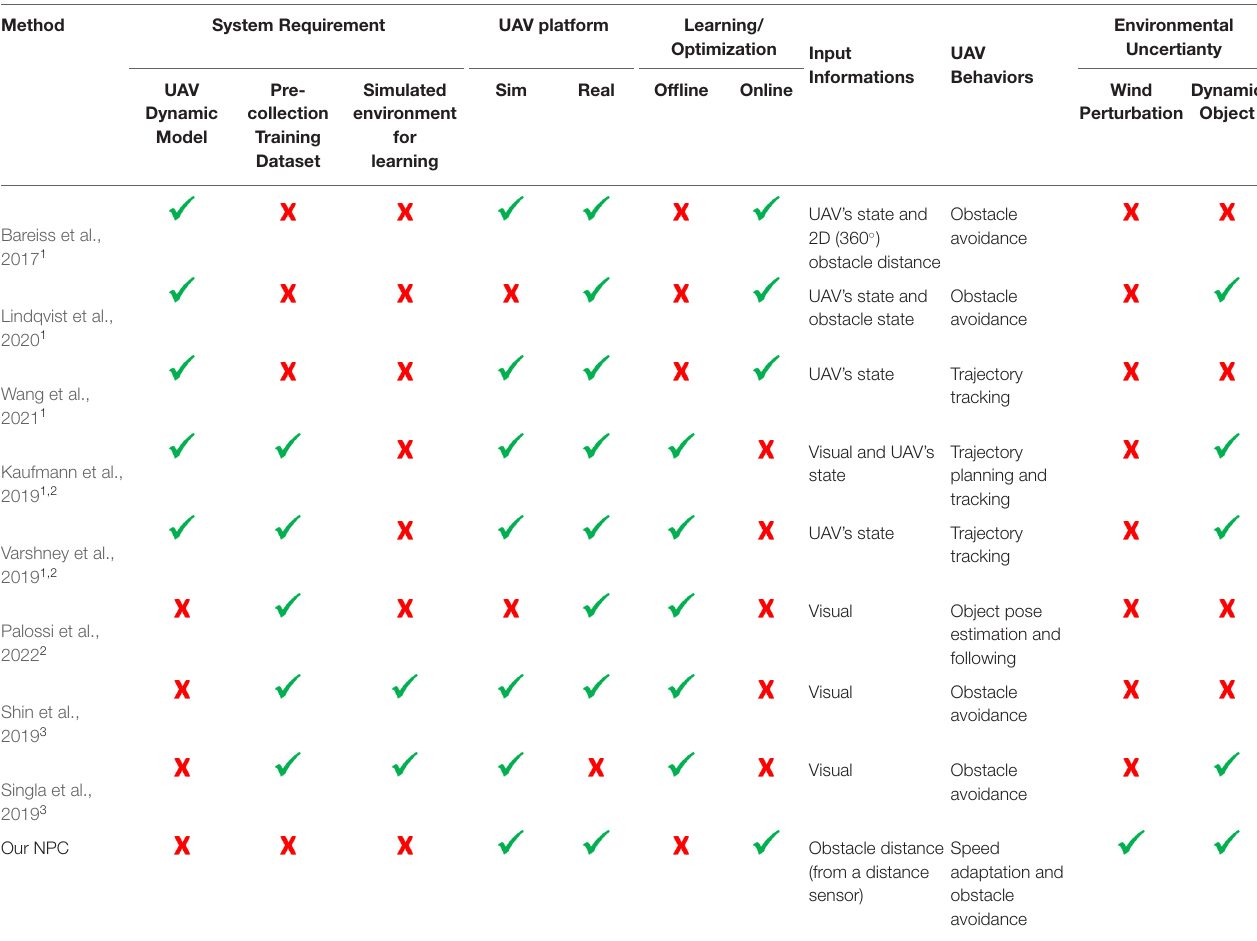
TABLE 2 | A comparison between our proposed and state-of-the-art methods in terms of system requirement for implementing each method, experimental UAV platform, offline/online learning or optimization process, input information required to perform a task, UAV tasks or behaviors, and environmental uncertainty.